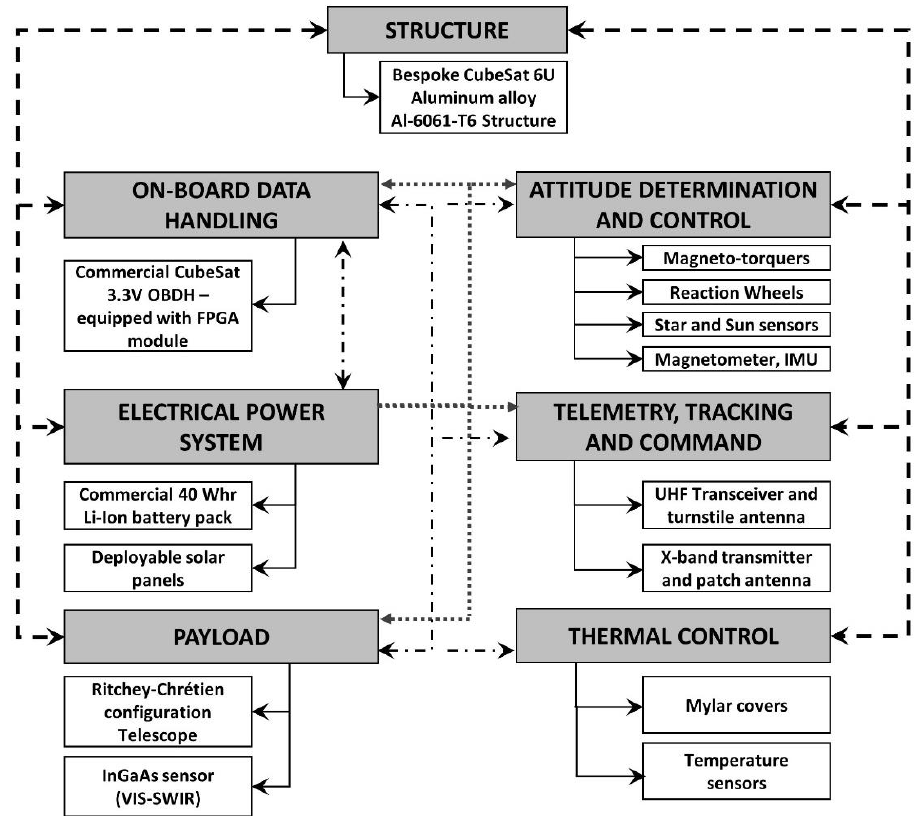
Figure 3. CubeSat sub-systems block diagram (dotted lines represent power lines, dashed-dotted lines represent data lines, bold dashed lines represent mechanical interfaces). UHF: Ultra-High Frequency; IMU: Inertial Measurement Unit.